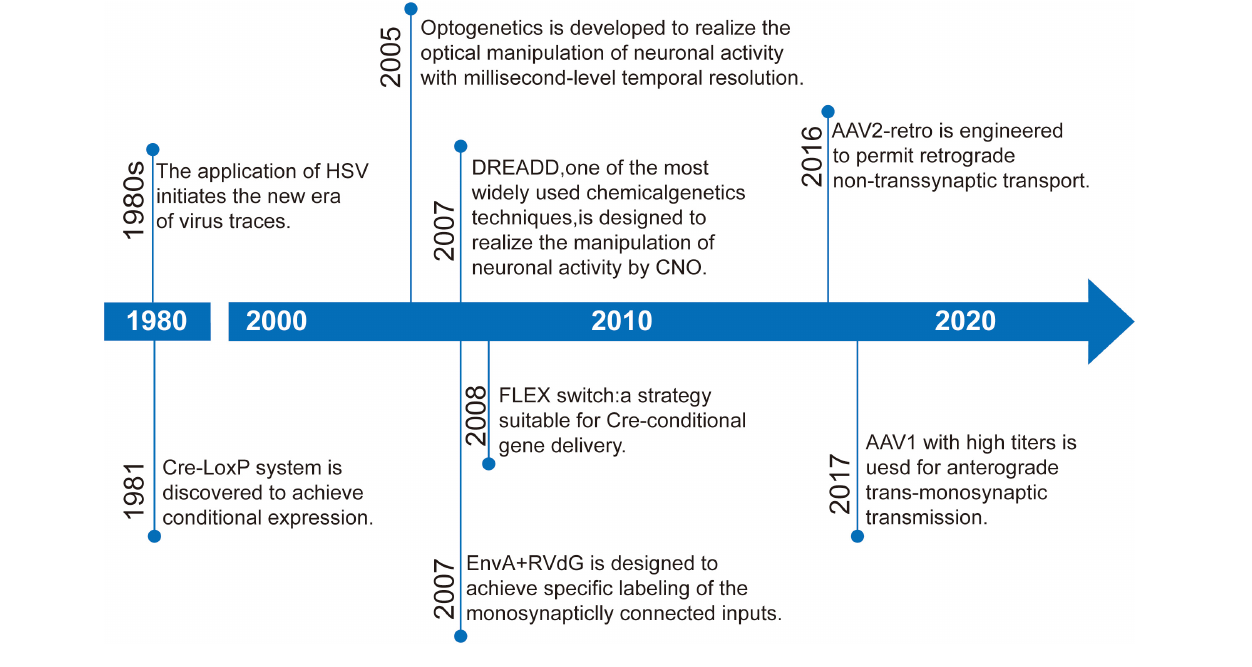
FIGURE 1 | Timeline of some important developments in strategies targeting neural